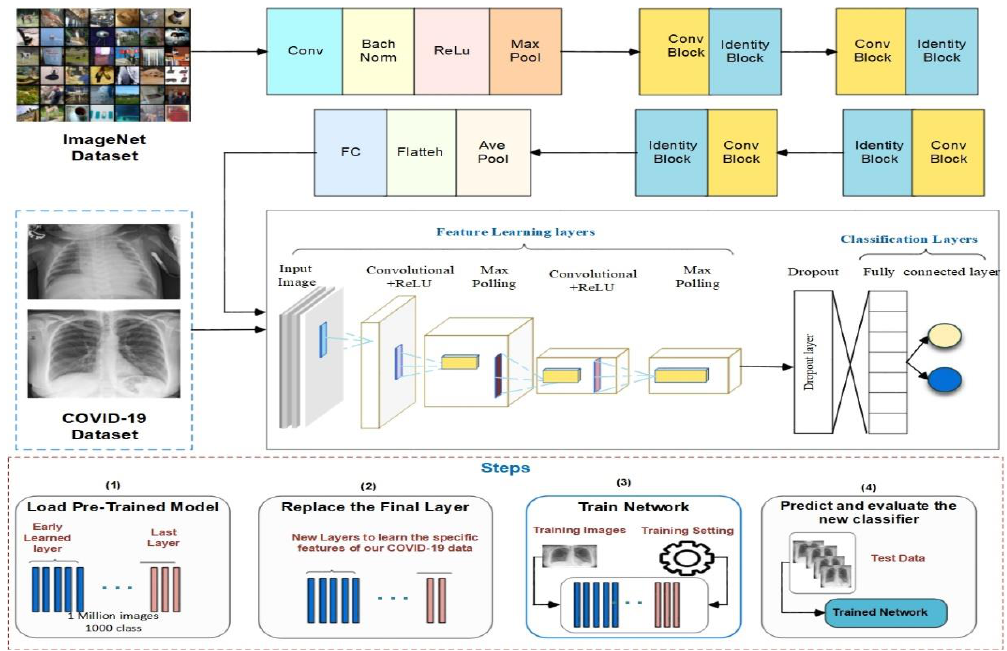
Figure 11. The proposed classification model architecture.